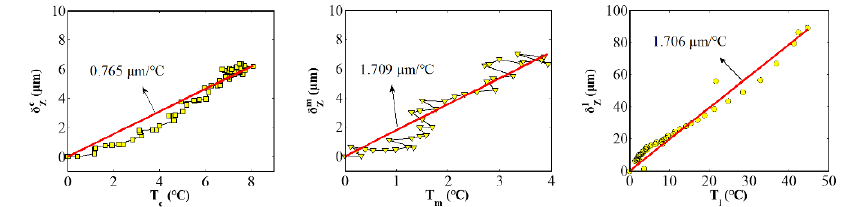
Figure 6. Thermal responses of deformations of the camera case, mount, and lens.